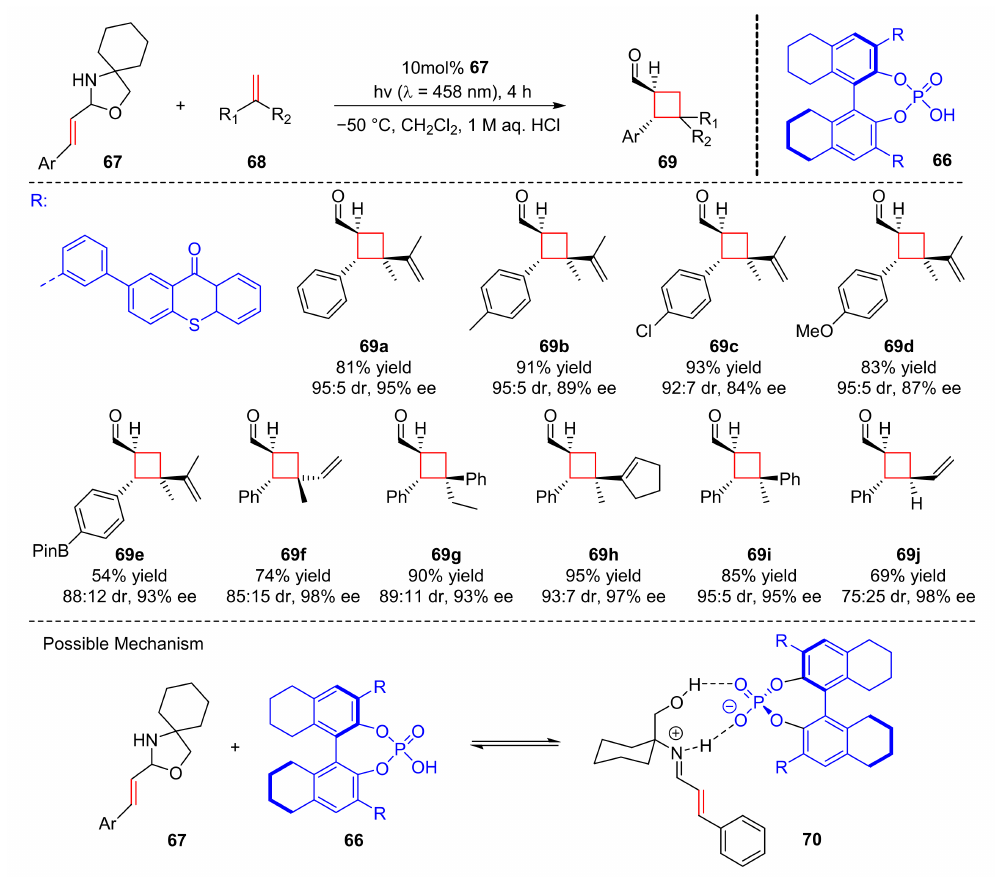
Scheme 16. Enantioselective [2+2] photocycloaddition of N,O-acetals and olefins. 2.3. Enantioselective Formation of 5-Membered Ring by Visible Light Catalysis In nature, 5-Membered ring compounds exist widely, and some five-membered het- erocyclic compounds, such as furan, pyrrole, and thiophene, are widely used in organic synthesis and have a variety of physiological activities as drugs. In 2017, MacMillan et al. reported an intramolecular α -alkylation of aldehydes ( 79 ) via a co-catalytic system (amine catalyst ( 80 ), iridium photocatalyst ( 81 ) and HAT catalyst ( 82 )) to obtain five-membered, six-membered, or seven-membered cyclic aldehydes ( 83 ) under the irradiation of blue LED light in good yields and enantioselectivity (up to 91% yield, up to 95% ee) (Scheme 19) [29]. This reaction could be used to prepare a variety of heterocyclic compounds containing nitrogen atoms and synthesize tetrahydropyran. In the scope of alkenes, trisubstituted and 1,2-disubstituted olefins were well tolerated. The proposed mechanism was conducted as follows. The substrates ( 79 ) combined with amine catalyst ( 80 ) to afford enamines ( 84 ). At the same time, under the irradiation of visible light, enamines ( 84 ) formed electrophilic radical ( 84a ) through SET initiated by iridium photocatalyst, which was added to olefins to produce nucleophilic radical ( 84b ). Nucleophilic radical ( 84b ) underwent HAT to gen- erate iminium ions ( 84c ); finally desired products ( 83 ) were obtained by releasing amine catalyst ( 80 ) from iminium ions ( 84c